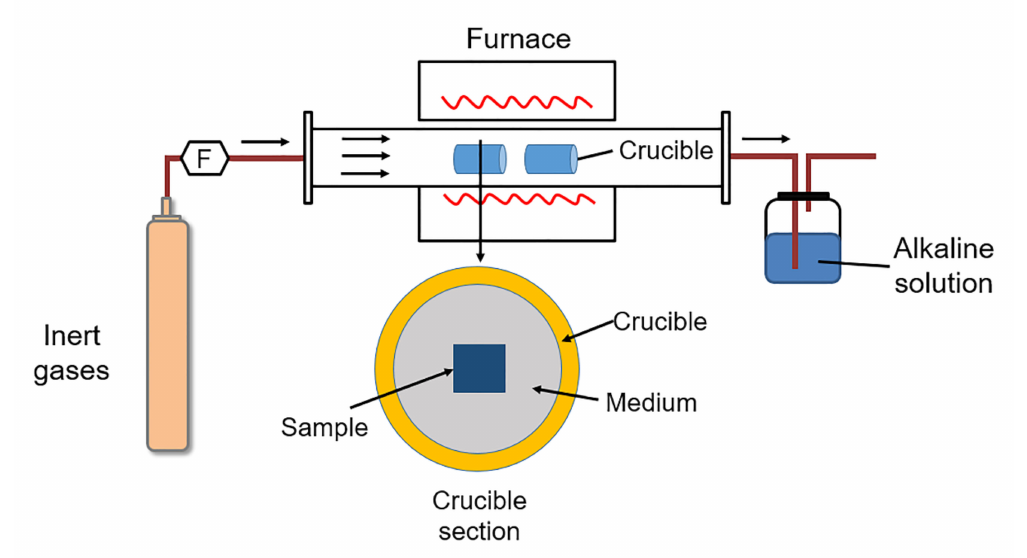
Figure 8. The mechanism diagram of metal penetration in the